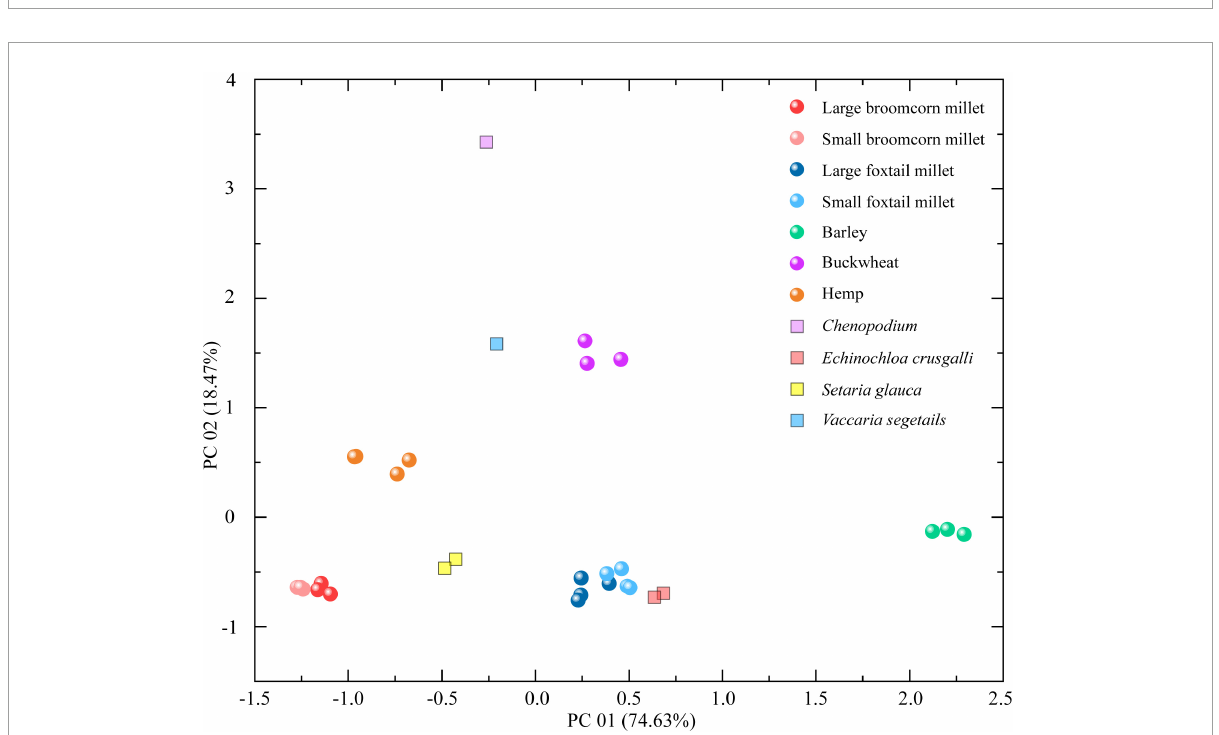
FIGURE5 The scatter diagram of the first two principal components of trace element results for plant remains from the Chashancun cemetery.